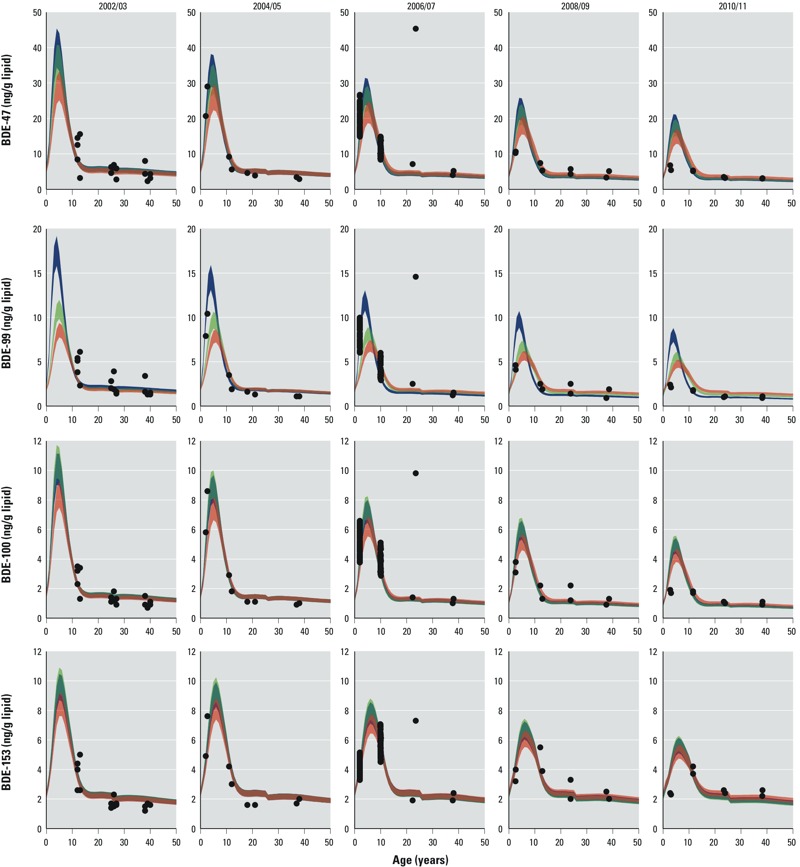
Modeled age–concentration profiles (blue: scenario A; green: scenario B; red: scenario C) fitted to the biomonitoring data (dots) of BDE-47, BDE-99, BDE-100, and BDE-153 in the female population. To increase the visibility of the data for the younger age groups, the x-axis ends at 50 years and the two oldest age groups are not shown. The concentrations in adults > 50 years of age equal the concentrations of adults < 50 years of age and therefore do not contribute additional information.